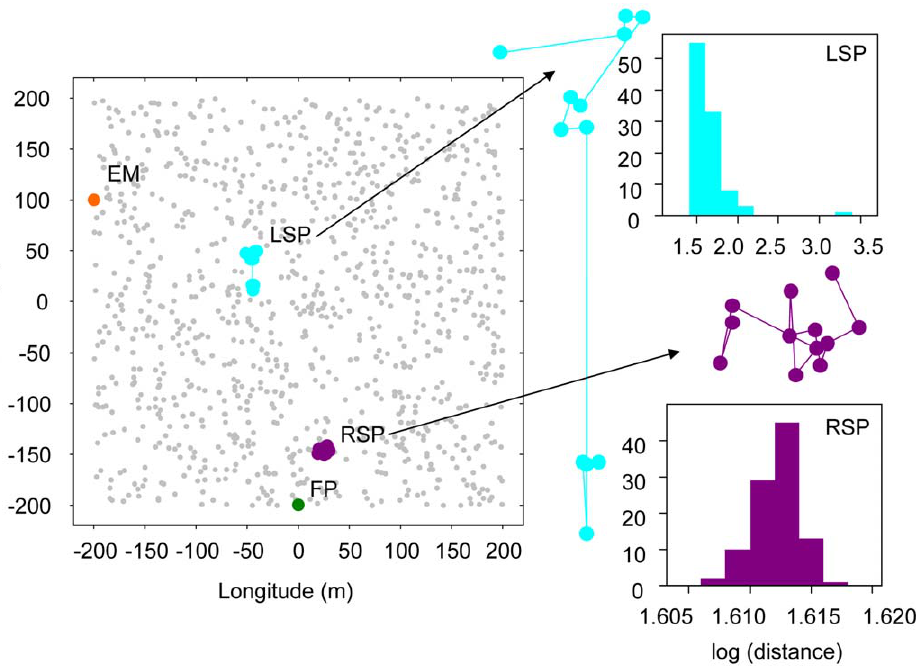
Figure 2. Spatial scenario considered for the IBM simulations. Grey points represent the centre of the HRs of the 1,000 simulated fishes following the biased-random walk described in the methods section. The path (individual Lagrangian trajectory) for one fishing trip (12 time steps) of the fishers following the behaviours described in the M&M are shown: the fisher fixed in one spot (FP), the fisher moving randomly along the edge of the scenario (EM), the random search pattern (RSP) and the Le´vy search pattern (LSP). A magnification of the RSP and LSP (at the same spatial scale) is provided to improve visualisation and to show the distribution of the distance travelled between two consecutive time steps during one simulation, presented on a log-scale (m).